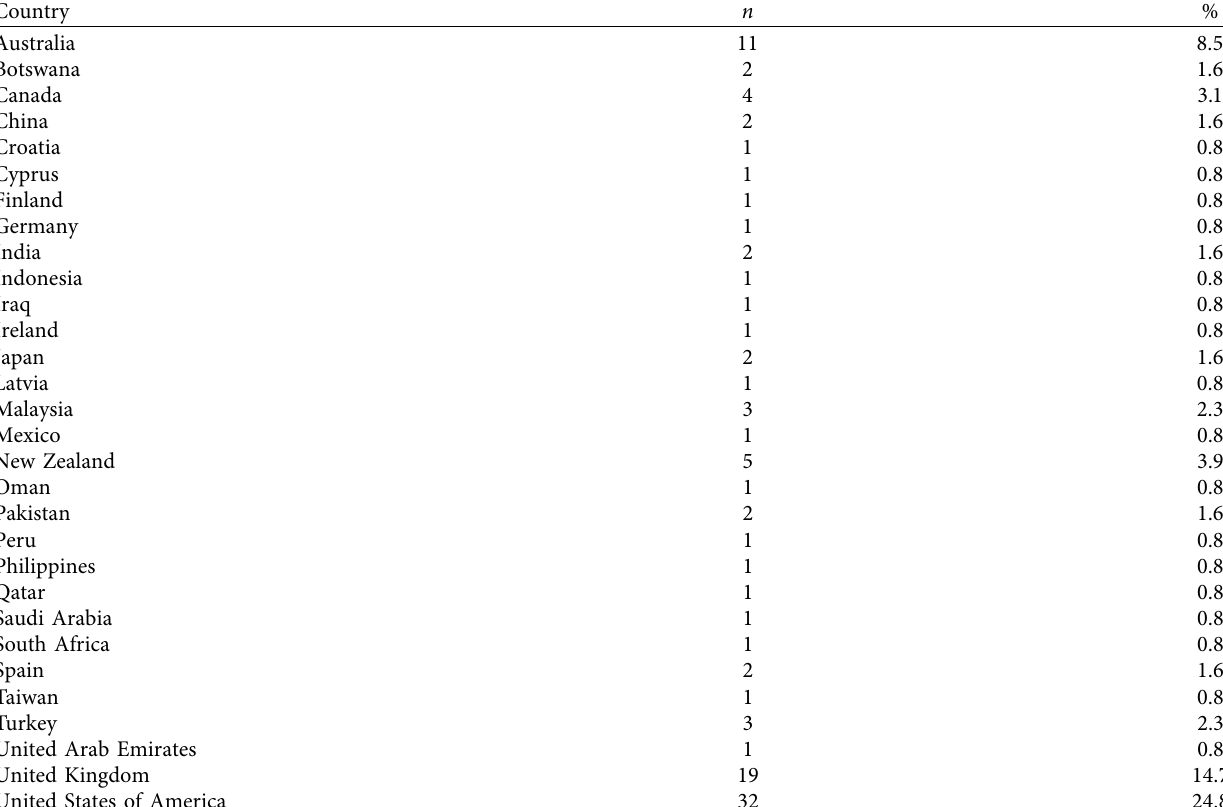
Figure 1: PRISMA Diagram. The flow of articles through the screening and searching process is shown, using the Preferred Reporting Items for Systematic Reviews and Meta-Analyses (PRISMA) 2020 guidelines Table 3: Study characteristics: country of study.